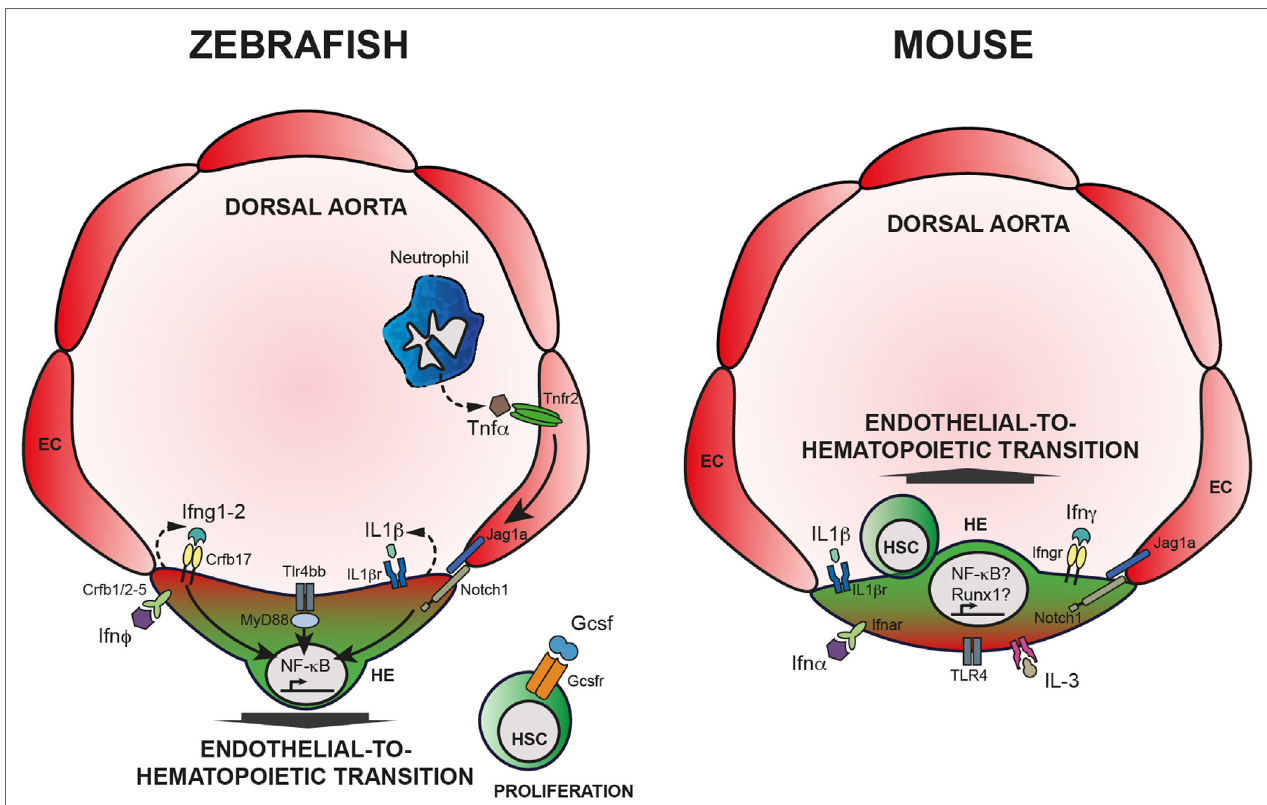
FiGURe 1 | inflammatory signaling is required for HSC emergence . Left panel: HSC specification in zebrafish embryos. Neutrophils produce TNF α that binds Tnfr2, expressed by endothelial cells (EC). Activation of Tnfr2 leads to upregulation of jag1a and activation of Notch signaling in the hemogenic endothelium (HE), ultimately leading to the activation of NF- κ B. Alternatively, Tlr4/Myd88 also induce NF- κ B, crucial for HSC specification throughout endothelial-to- hematopoietic transition. Downstream of Notch1 activation, Ifng participates in HSC specification in a cell autonomous fashion. IL-1 β signaling, downstream of the TLR4–MyD88–NF- κ B axis has also an impact on HSC emergence as does Ifn- ϕ . Finally, Gcsf acts on newly generated HSCs and contributes to HSC proliferation; however, the mechanism is still unclear. Right panel: HSC specification in mouse embryos. Contrary to zebrafish embryos, it is still unclear how inflammatory pathways are being regulated in the developing embryo, or what are the sources of inflammatory cytokines. Nevertheless, it is clear that IFN- α , IFN- γ , as well as Il-1 β , IL-3, and TLR4 are required for proper HSC specification, possibly engaging Notch1 signaling and Runx1 and/or NF- κ